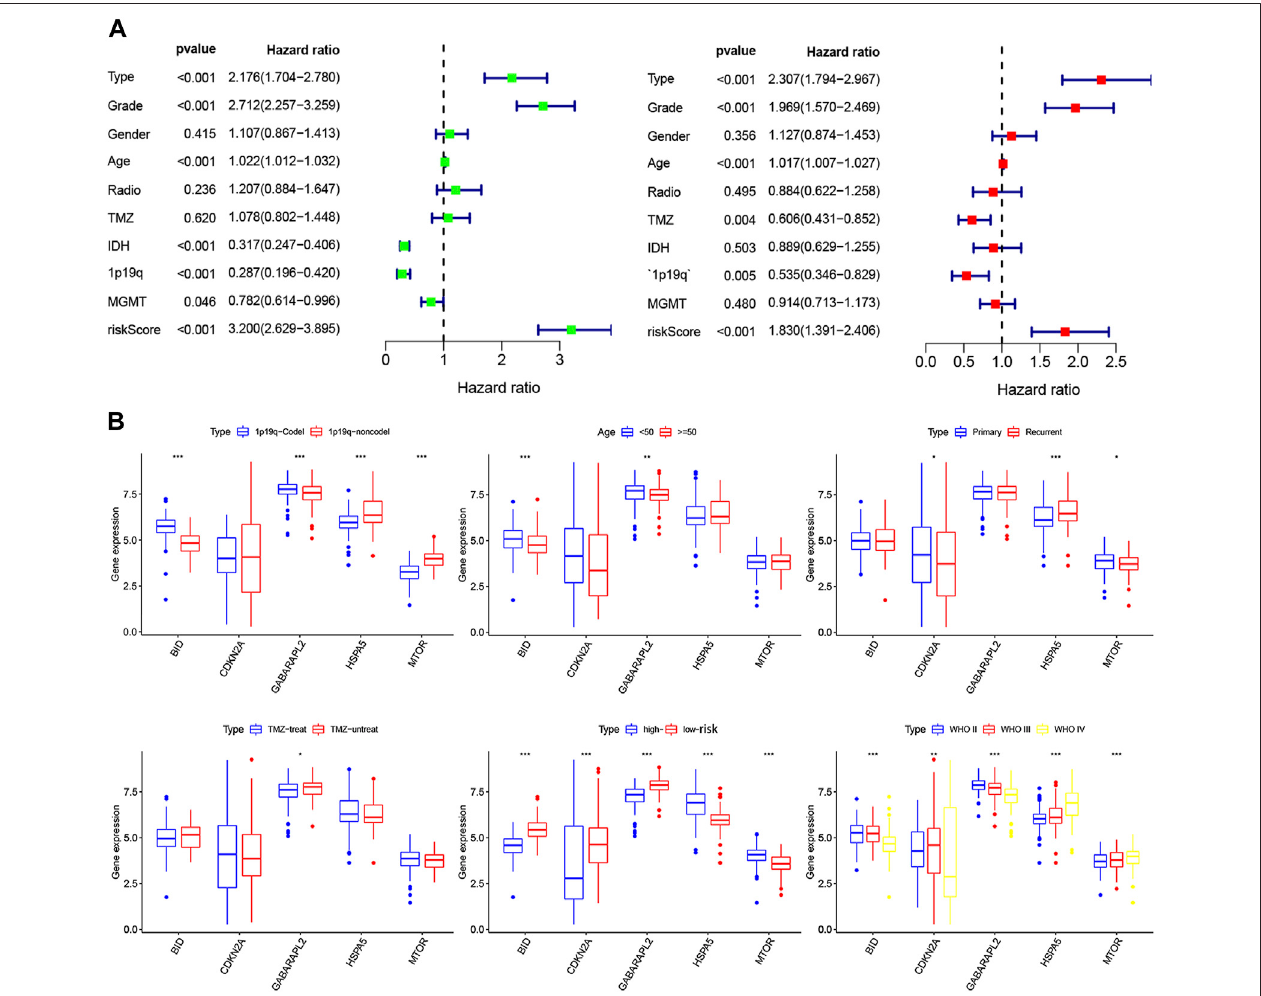
FIGURE 4 | (A) Univariate and multivariate analyses screened clinical factors related to prognosis. (B) The relationship between the expression of fi ve prognosis- related genes and clinical characteristics (* p < 0.05, ** p < 0.01, *** p < 0.001).